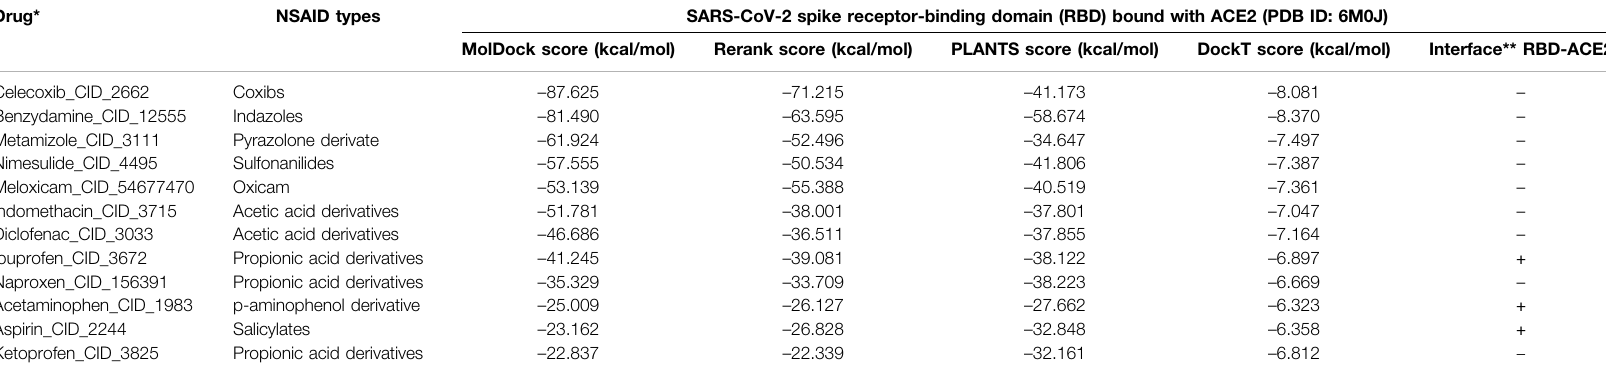
TABLE 1 | Results of the binding energies of the NSAIDs considered in this study with the SARS-CoV-2 Spike Receptor-Binding Domain (RBD) complex bound with ACE2 (PDB ID: 6M0J).